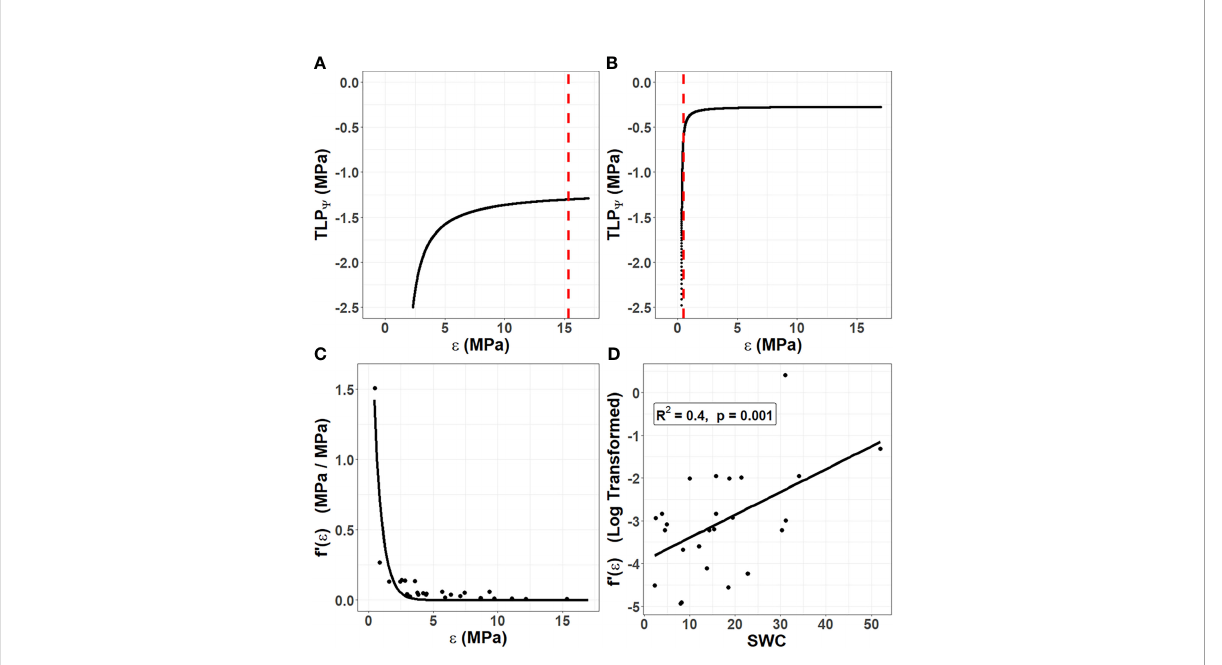
FIGURE 1 The unique role of cell wall biomechanics in succulent species. Using data from 25 species in the Caryophyllales published by Ogburn and Edwards (2012), the turgor loss point (TLP Y ) was simulated according to Equation 2 by holding the osmotic potential at full hydration ( p O ) constant for each species and varying the bulk modulus of elasticity ( e ). (A) In non-succulent species, such as Calandrinia colchaguensis , the true value of e (dashed line) intersects at the fl at portion of the curve. Hence, changes to e have little to no effect on the TLP Y . (B) In some succulent species, such as Grahamia bracteata , the true value of e intersects at the curved potion of the line, meaning changes to e affect the TLP Y . A quantitative estimate of the extent to which changing e affects the TLP Y was generated by fi nding the derivative of the curve at the point where the dashed line intersects [f ’ ( e )]. (C) Among the 25 species, lower values of e result in exponentially higher values of f ’ ( e ). An exponential curve still fi t these data well when the species with the highest f ’ ( e ) value was removed (data not shown). (D) Among the 25 species, saturated water content (SWC) correlates with the f ’ ( e ), after this value has been log